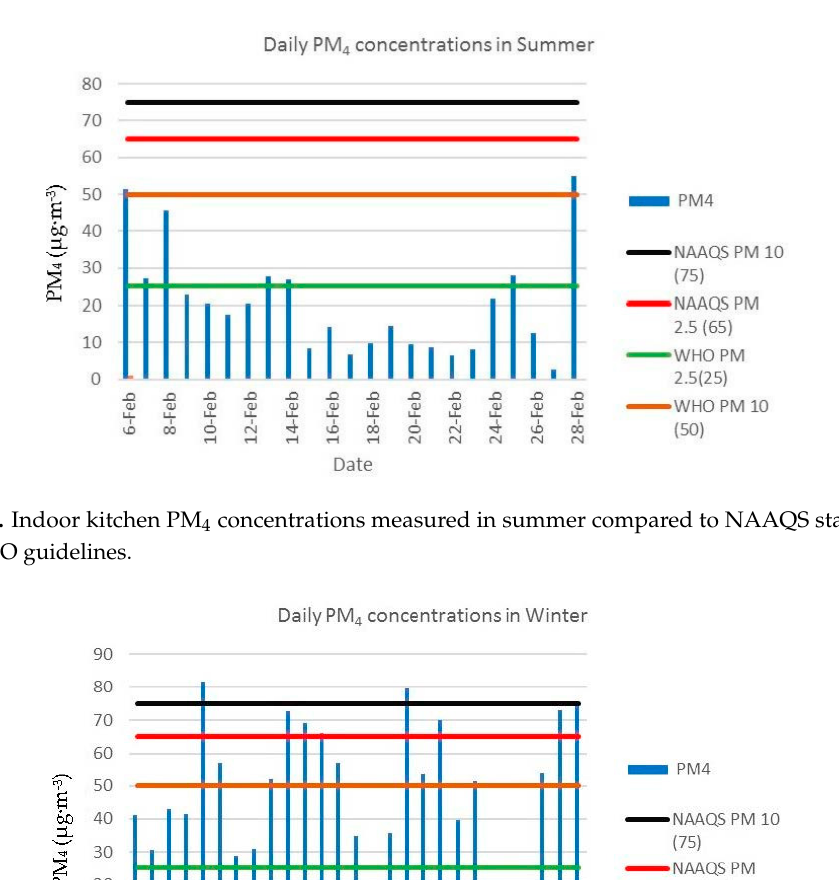
Figure 5. Indoor kitchen PM 4 concentrations measured in winter compared to NAAQS standards and WHO guidelines.